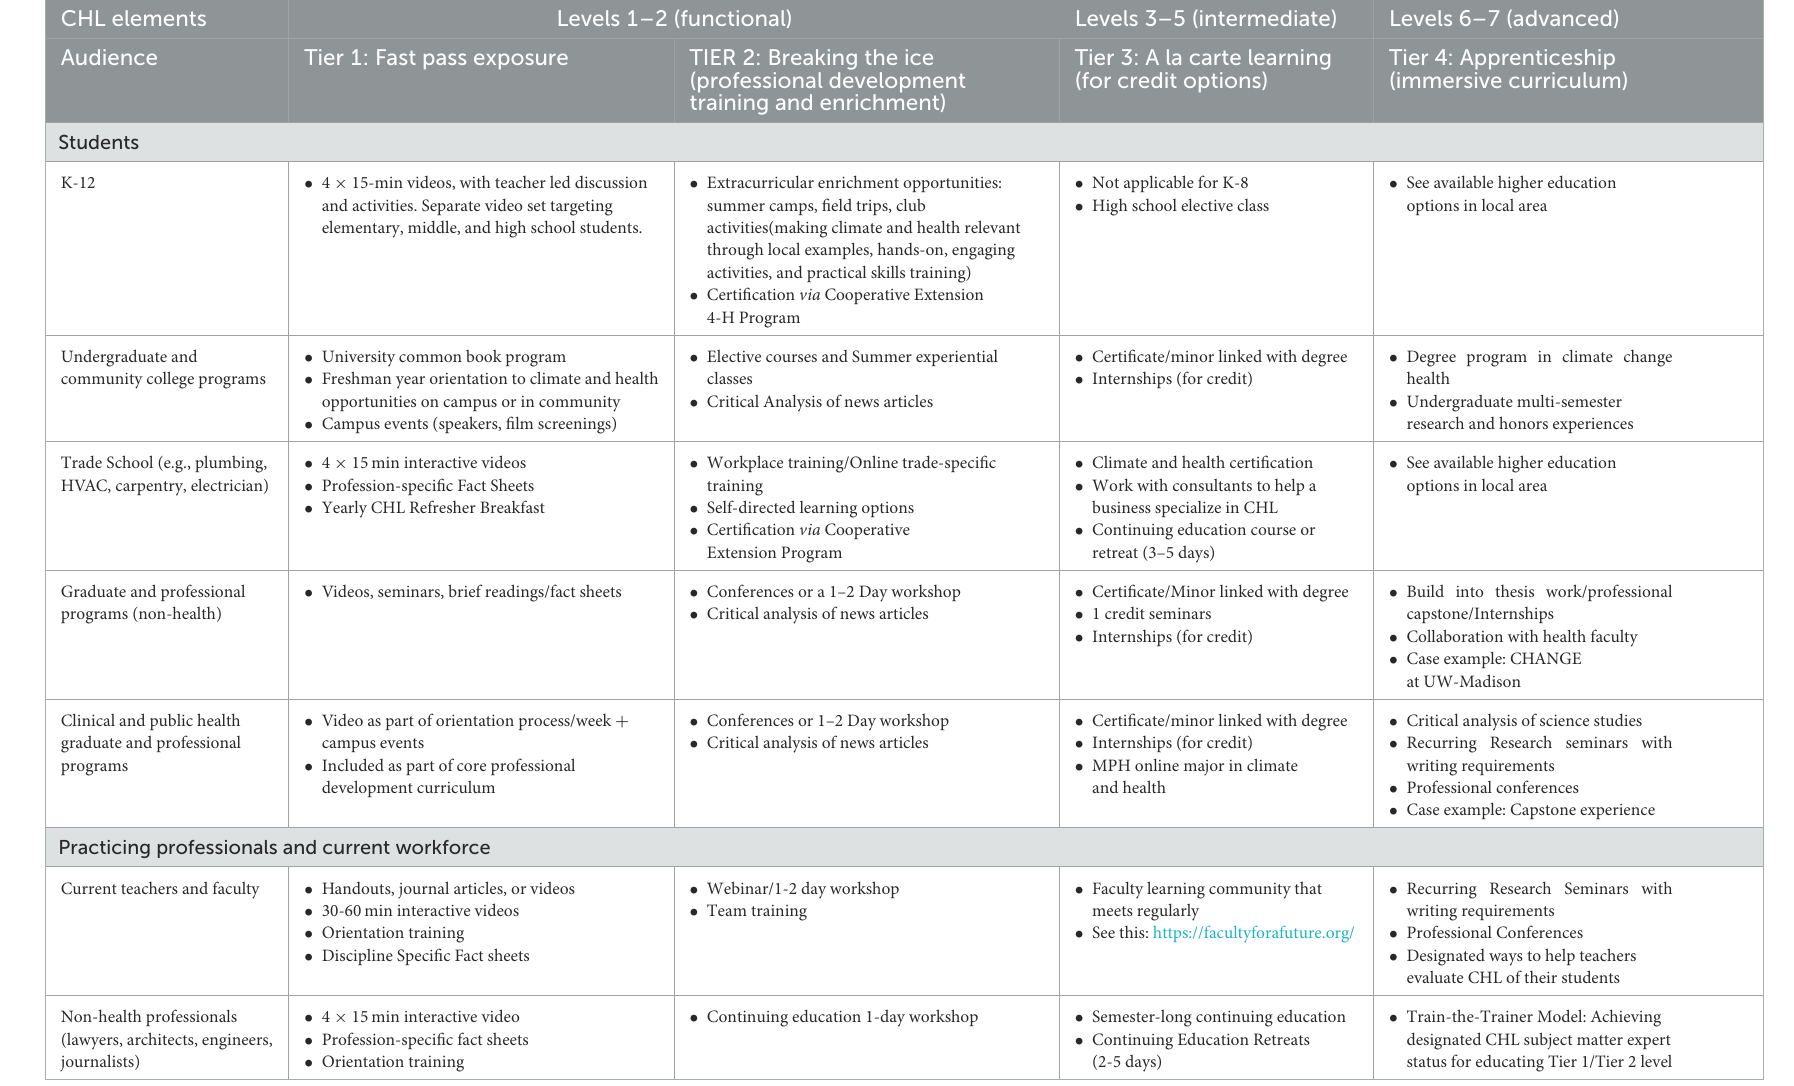
TABLE 1 Blueprint for building climate and health literacy (CHL) and professional adaptability by